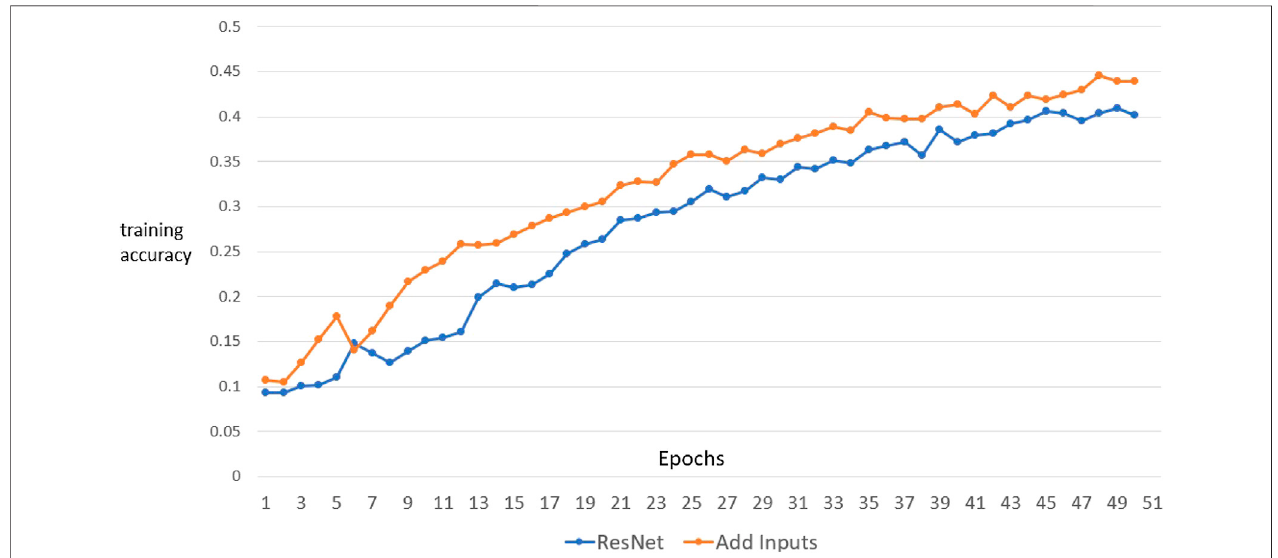
FIGURE8| FittingtheoriginalResNetarchitectureand theadd-inputs modelto3,000 images fromthe CIFAR-30 dataset. The add-inputs model learnsfaster and has a higher fi nal test accuracy than the ResNet network.